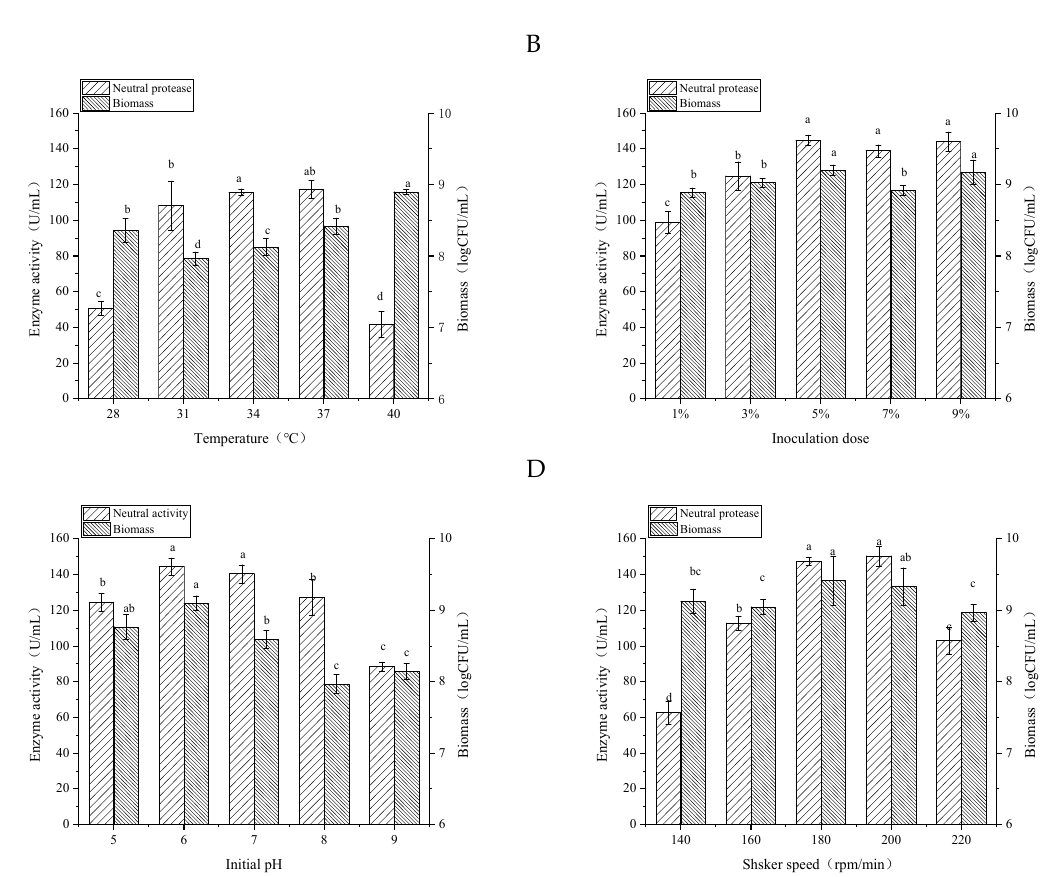
Figure 4. Effects of temperature ( A ), inoculation dose ( B ), initial pH ( C ), and shaker speed ( D ) on the enzyme activity and biomass of B. velezensis . Bars with different letters differ significantly ( p < 0.05).